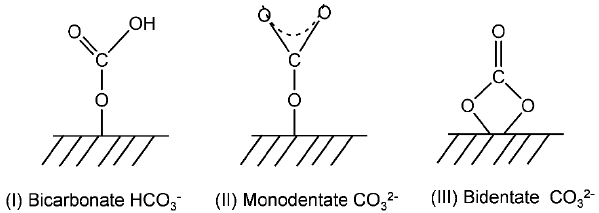
Figure 4. DRIFT spectra of: ( a ) xMZ–HD; and ( b ) xMZ–CT mixed oxides following subtraction of corresponding pure zirconia spectra.